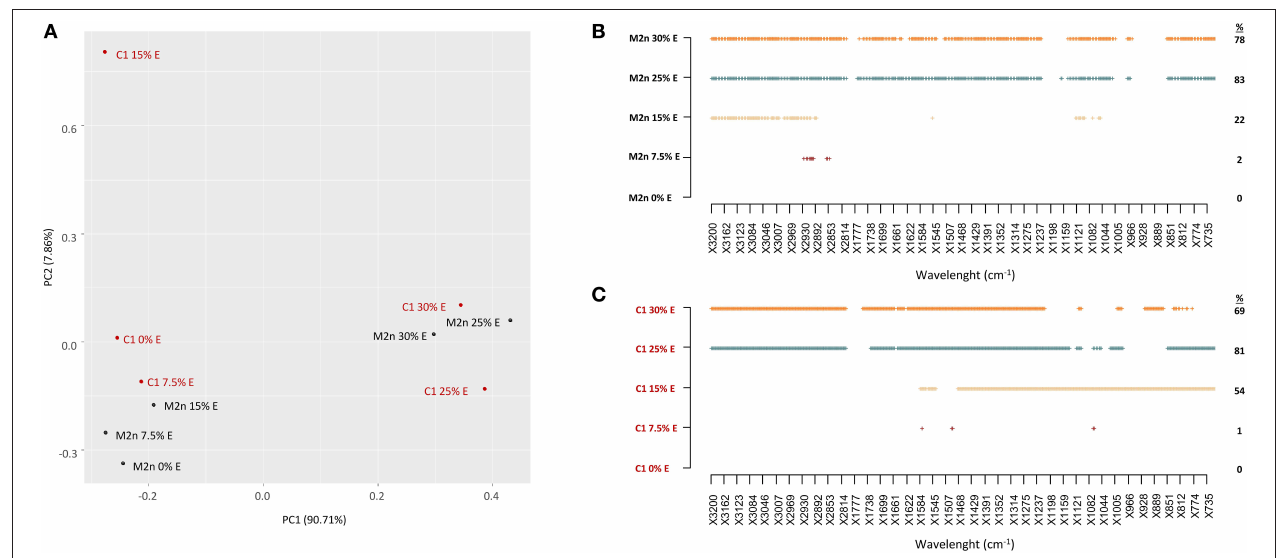
FIGURE 4 | Stress response of S. cerevisiae M2n and C1 strains to increasing ethanol concentrations. (A) PCA score plot obtained from the IR spectra of M2n (black) and C1 (red) strains at 0, 7.5, 15, 25, and 30% (v/v) ethanol. (B,C) SWA patterns of (B) M2n and (C) C1 strains at 0, 7.5, 15, 25, and 30% (v/v) ethanol. All significant different wavelengths ( p < 0.01) between M2n and C1 spectra at the tested concentrations and those of the respective controls (cells directly resuspended in water) are reported as dots.